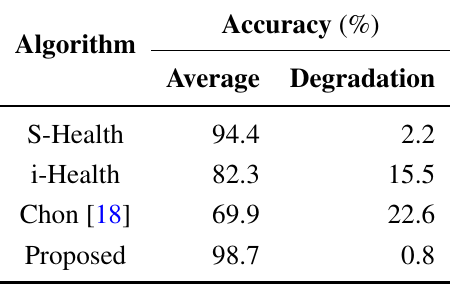
Table 4. Performance for time-varying device pose in walking step